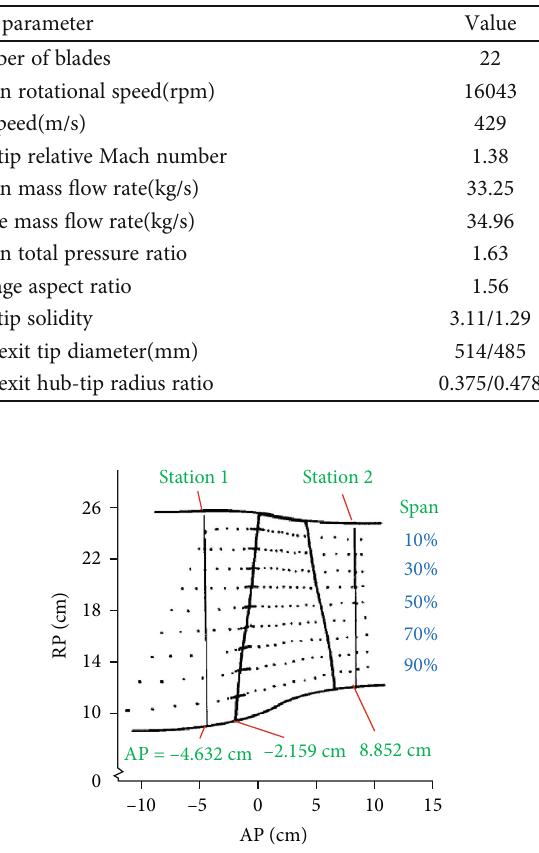
Table 1: Basic parameters of Rotor 67.